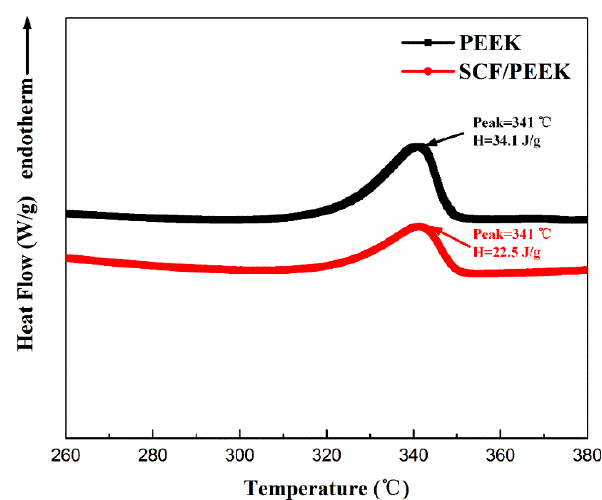
Figure 2. Differential scanning calorimetry (DSC) analysis of PEEK and short carbon fiber reinforced (SCFR)/PEEK composites. Table 2. The thermal analysis results of PEEK and SCFR/PEEK composites.